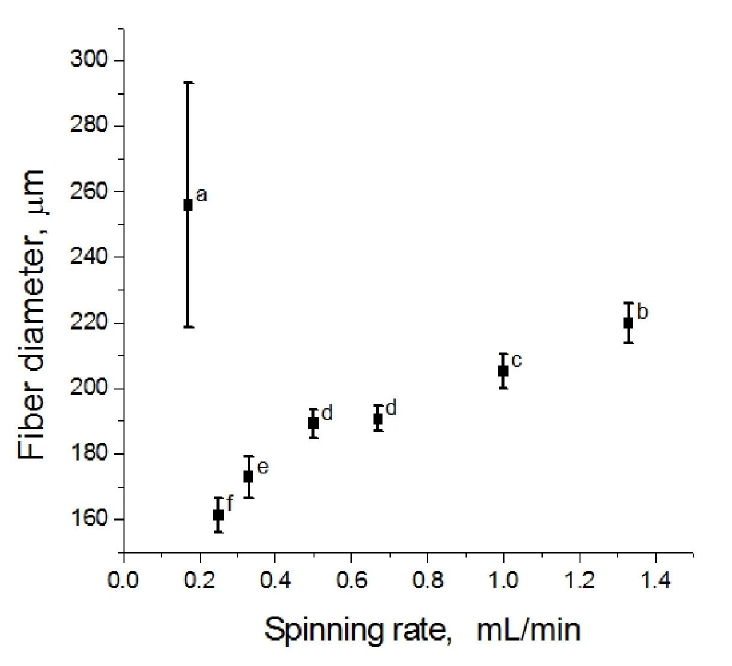
Figure 6. Average fiber diameter as a function of spinning speed (a > b > c > d > e > f, p <